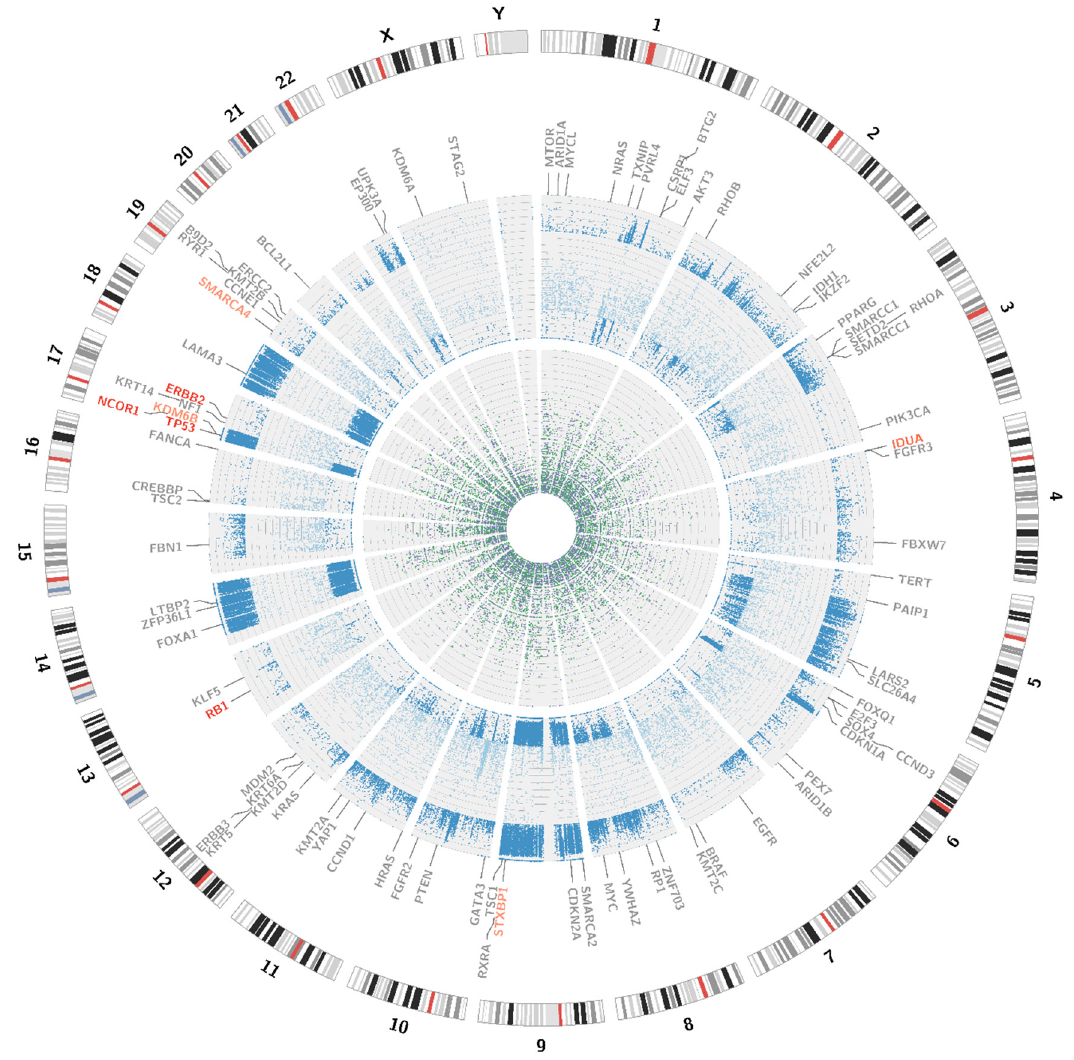
Figure 5. Visualisation of SNPs, insertions and deletions. The external circle represents an ideogram, while the internal circles represent the distribution of mutations. The dark blue dots stand for the loss of heterozygosity events; the light blue dots for novel mutations. The green dots represent insertions and the purple dots represent deletions. All the genes, analysed for the presence of somatic mutations are visible on the graph, the affected genes are marked red. Table 2. Selected mutations with a potential impact on bladder cancer development. Clinical significance based on